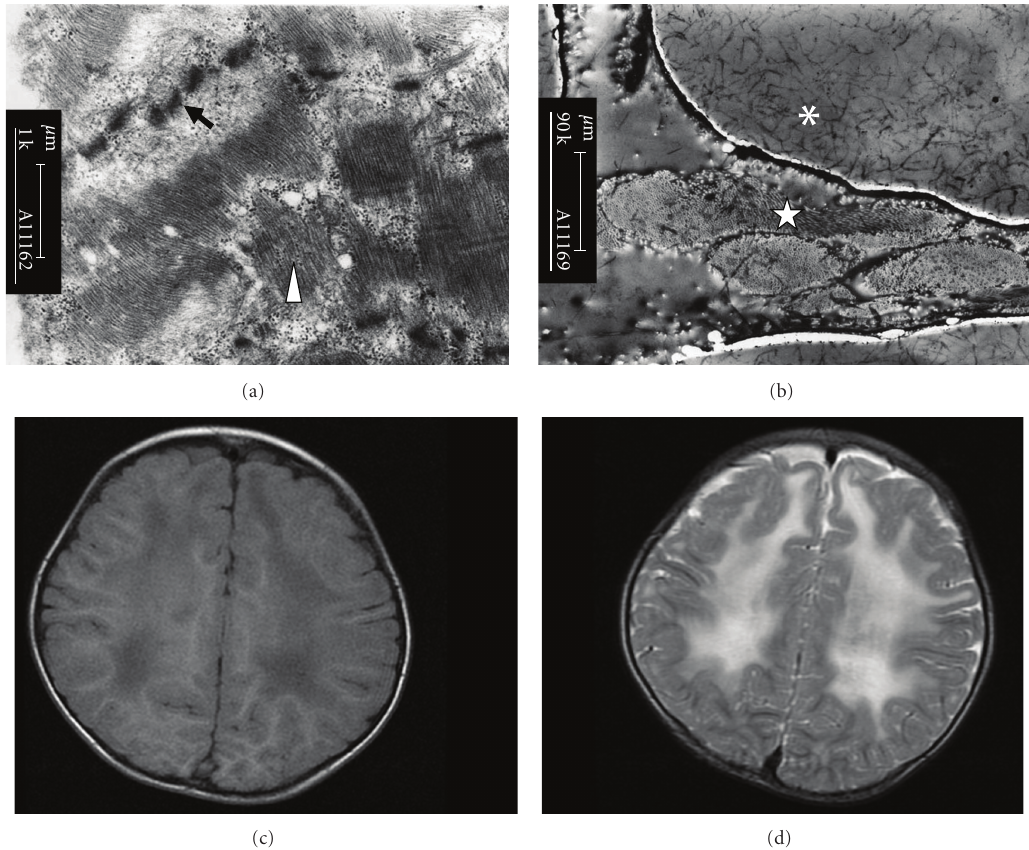
Figure 6: Muscular ultrastructure and brain MRI findings in a patient with congenital muscular dystrophy. In Figure 6(a), the myofibril Z lines in a muscle cell were ruptured ( ↑ ), and the filaments between Z lines were arranged disorderly ( degeneration of myofibrils ( ∗ ) in a muscle cell with completely vanished sarcolemma, and large quantity of collagenous fibers ( observed in the endomysium (Bar = 1 μ m). Figures 6(c) and 6(d) were cranial MRI findings revealing the reduced signal intensity in T1WI while increased one in T2WI, respectively, in bilateral frontal and parietal lobes, both indicating